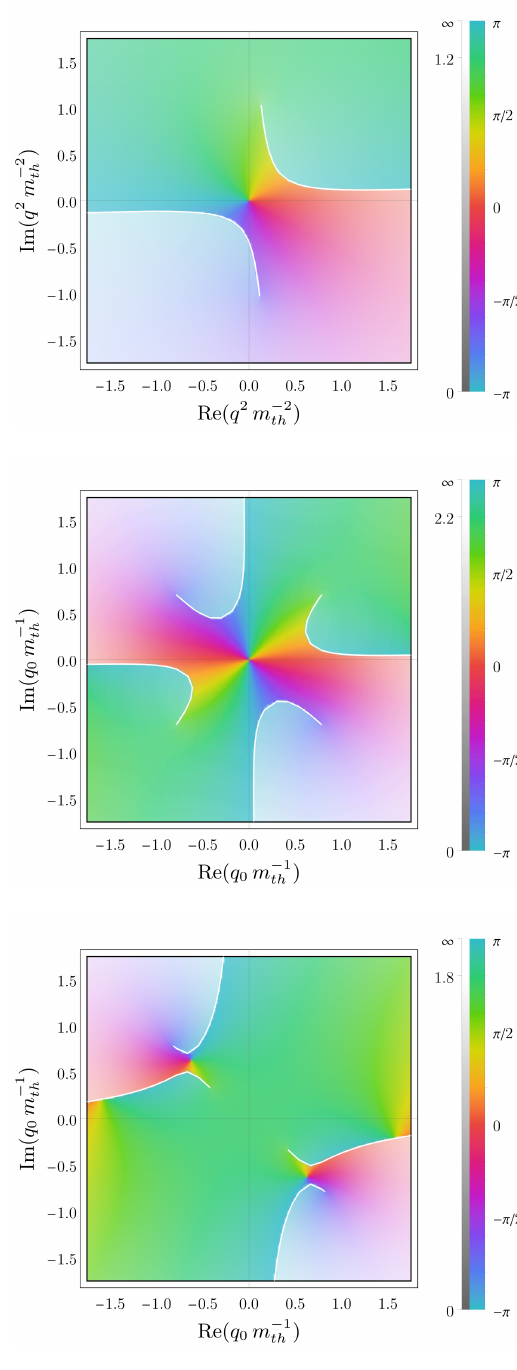
Figure 22 . Pole structure of the graviton propagator for Z < M 2 /m 2 in the q 2 -plane (top panels) q 0 -plane (center panels) and q 0 -plane with the i(cid:15) -prescription implemented (bottom panels). The figures in the left column are obtained with the “standard” prescription for the position of the branch cuts. The figures on the right instead implement the rotation of branch cuts according to eq. (6.5) with θ = π/ 30 . This prescription, in combination with the i(cid:15) -prescription, is used here to move branch cuts and branch points suitably to allow for an analytic Wick rotation from the Euclidean to the Lorentzian and vice versa. Indeed, when both i(cid:15) -prescription and branch cut rotations are applied, the first and third quadrants of the q -plane are free from obstructions (figure 0 on the bottom-right panel) and an analytic continuation can be